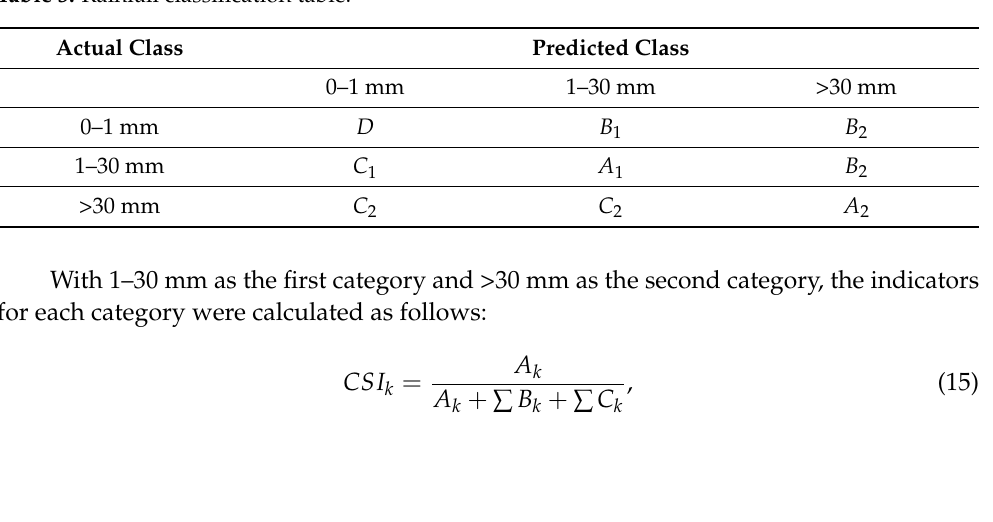
Table 3. Rainfall classification